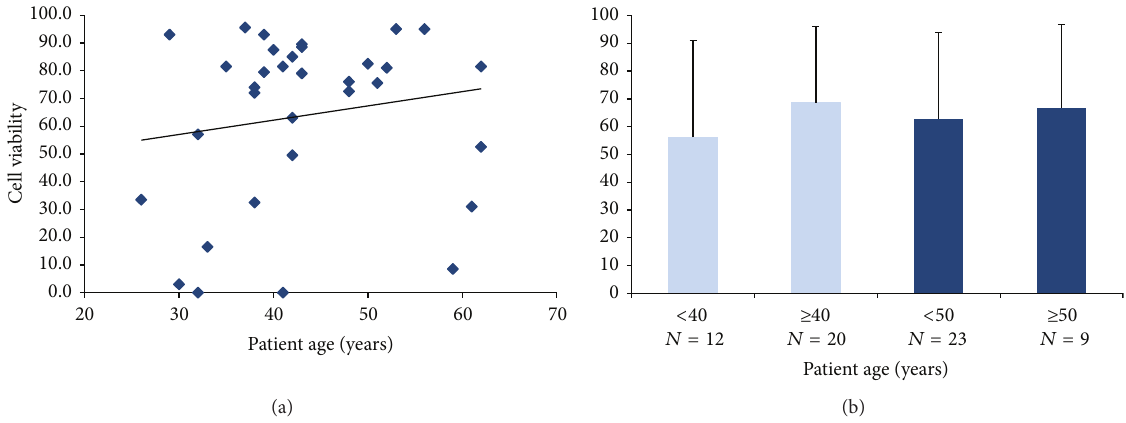
Figure 5: Initial ASC viability relative to patient age. (a) There was a modest trend toward increasing ASC viability with advancing patient age. (b) ASC viability was compared relative to patient age across 4 cohort groups: < 40 years ( 𝑁 = 12 ) versus ≥ 40 years ( 𝑁 = 20 ); < 50 years ( 𝑁 = 23 ) versus ≥ 50 years ( 𝑁 = 9 ); and < 40 years ( 𝑁 = 12 ) versus ≥ 50 years ( 𝑁 = 9 ). No significant differences in ASC viability were observed between any of the age cohorts; 𝑃 > 0.05